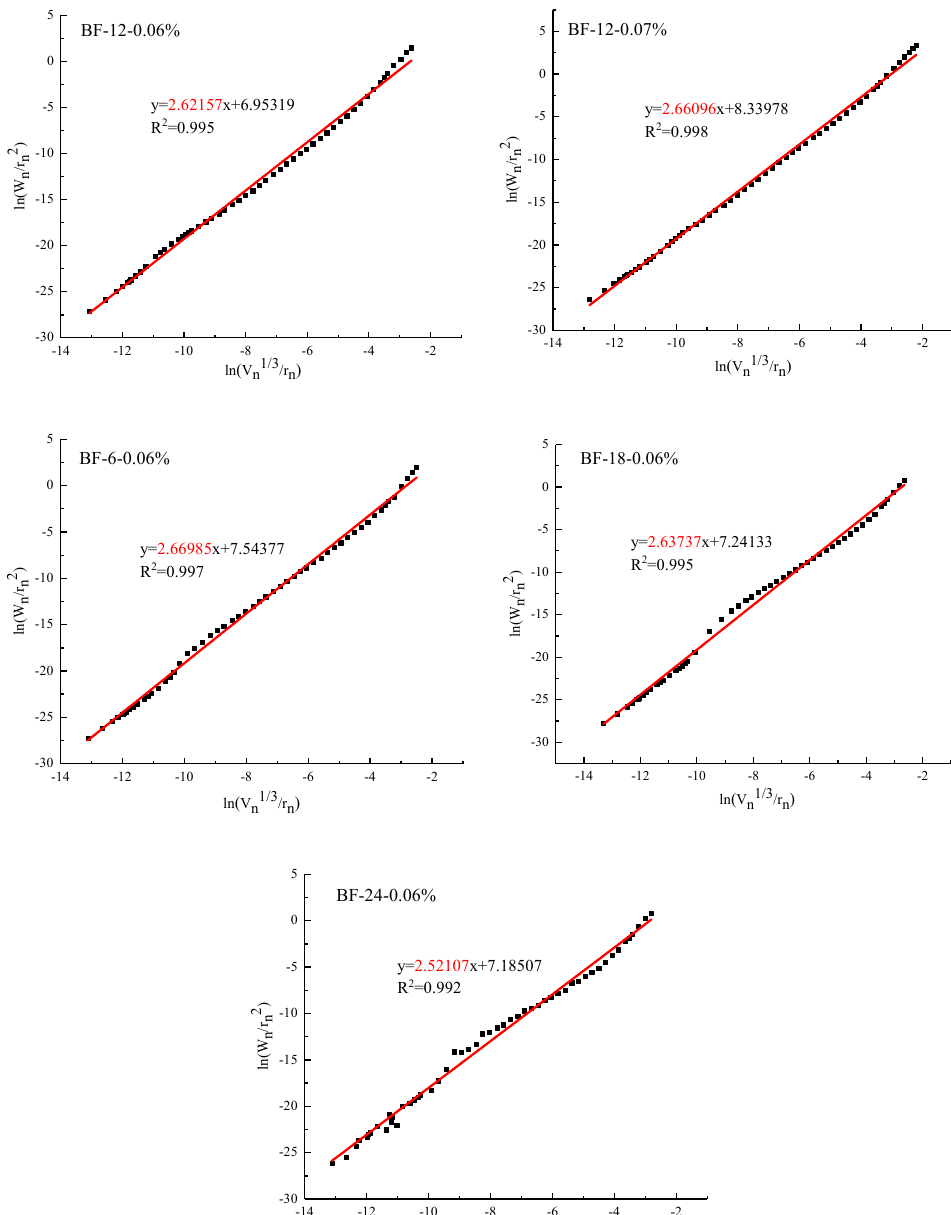
Figure 9. Calculation results of pore surface fractal dimension of BFRCs.